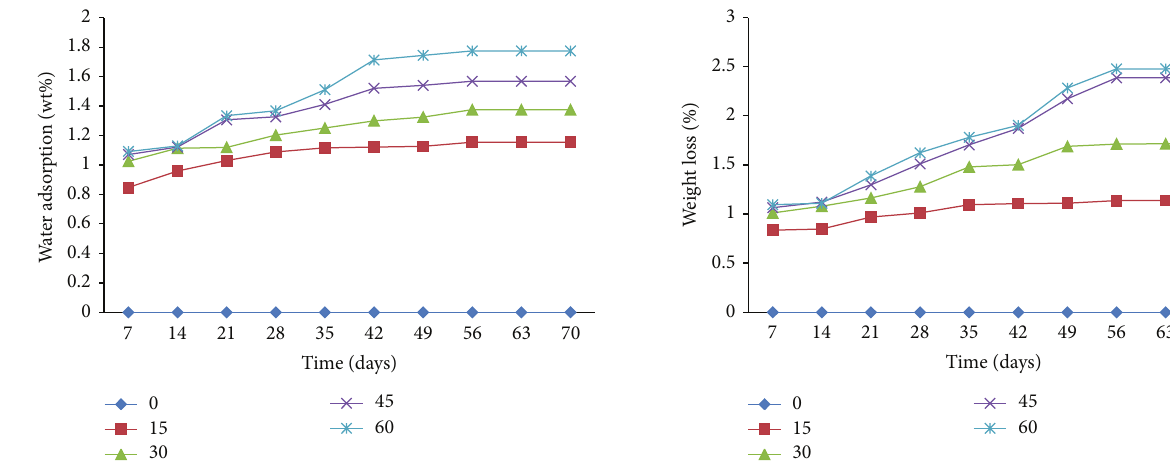
Figure 5: Water absorption in the presence of MA-g-PE.